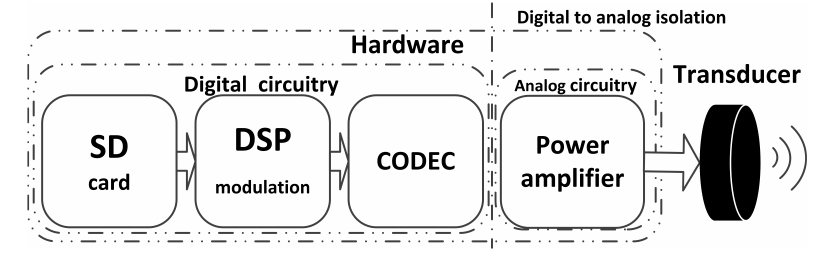
Figure 4. Functional diagram of the transmitter.